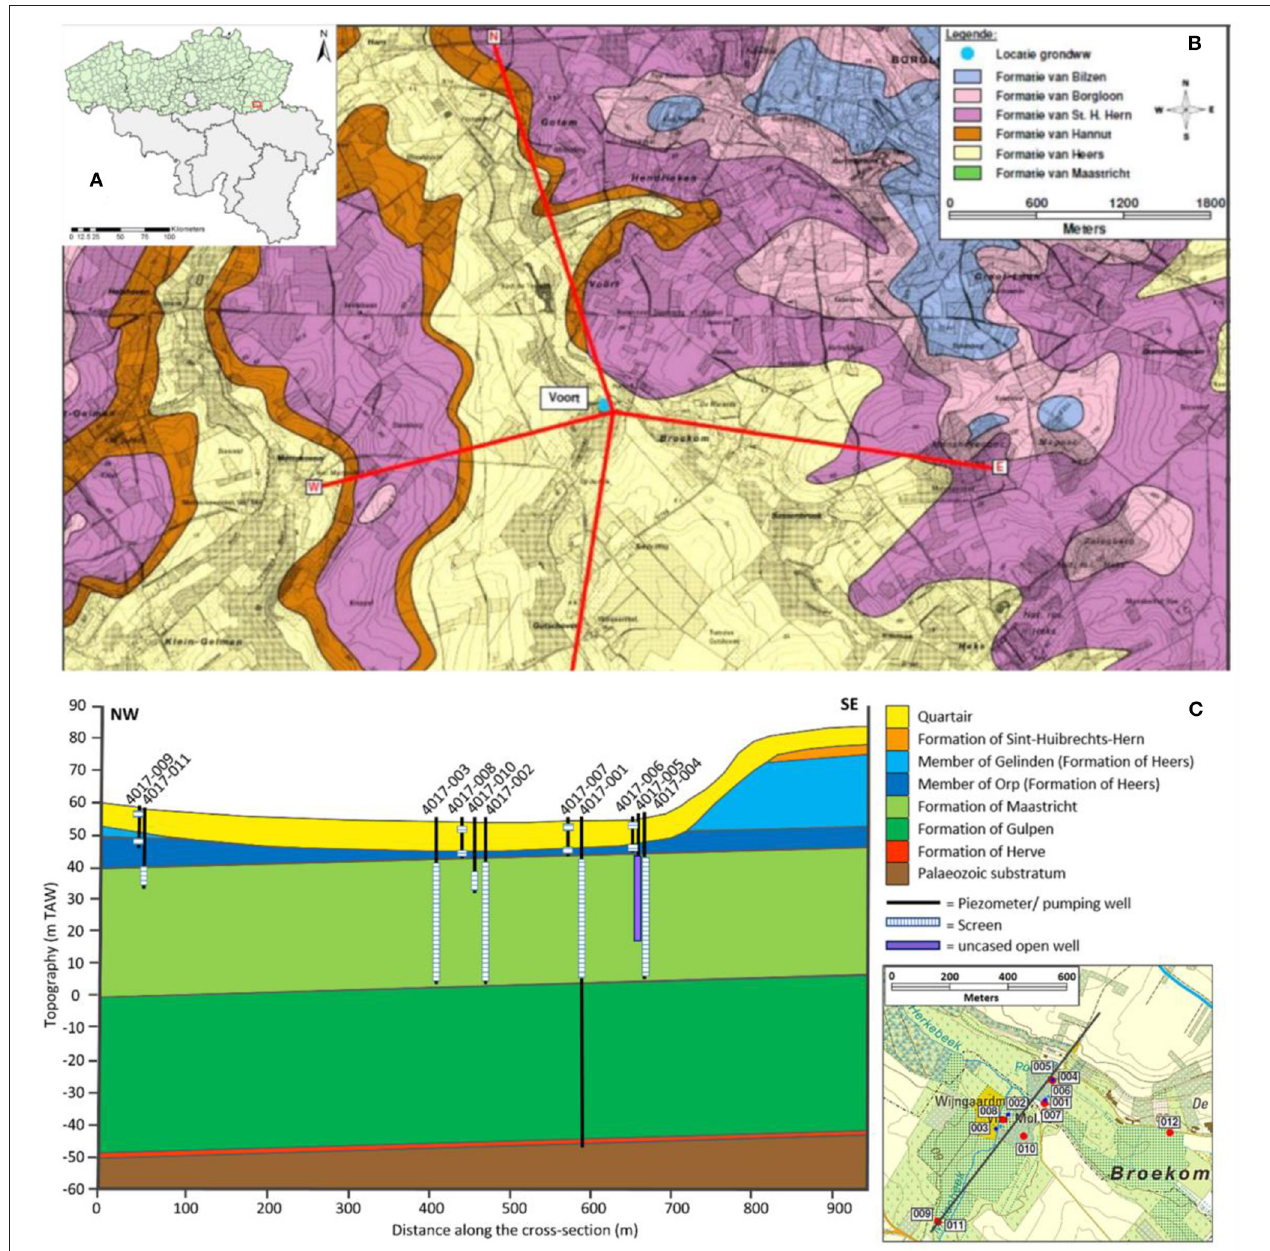
FIGURE 1 | (A) Map of Belgium and indication the extraction site (red). (B) Geological map of the study area. (C) Plan map and cross-section through the center of the extraction site.